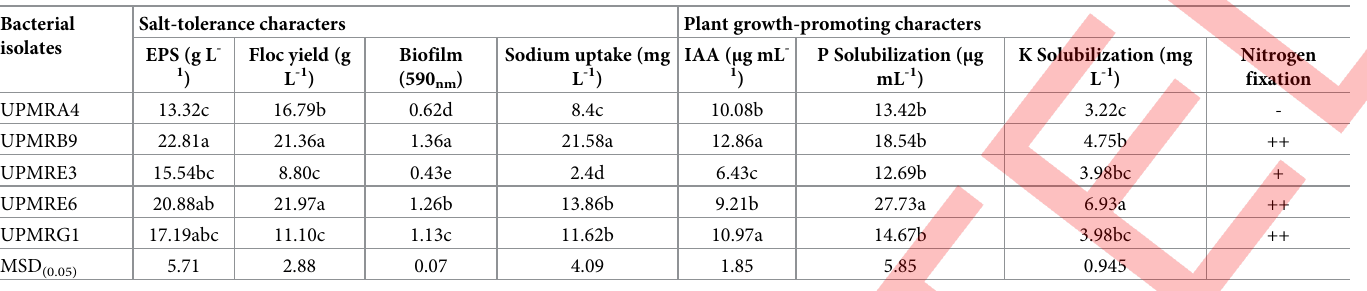
Table 1. Salt-tolerance and plant growth-promoting traits of selected bacterial isolates under 1M NaCl concentration.